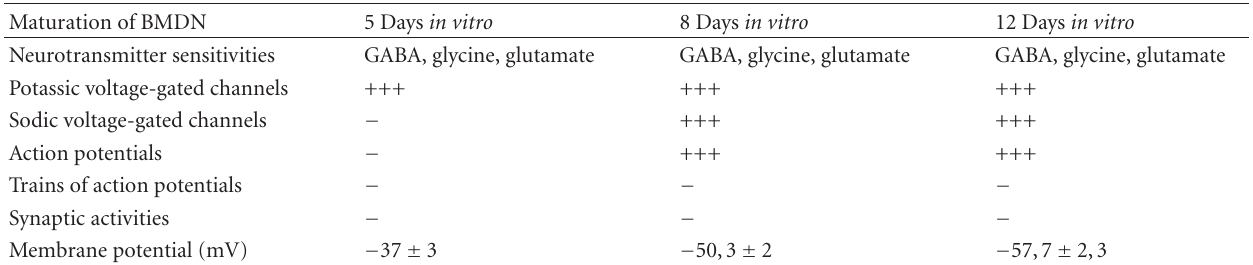
Table 1: Maturation steps of bone marrow derived neuron-like